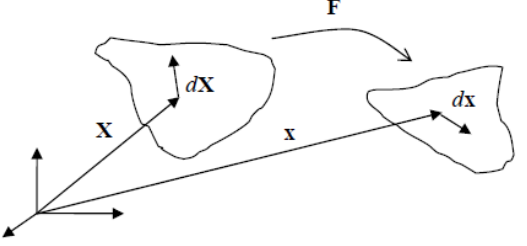
Figure 23. The deformation gradient acting on a line